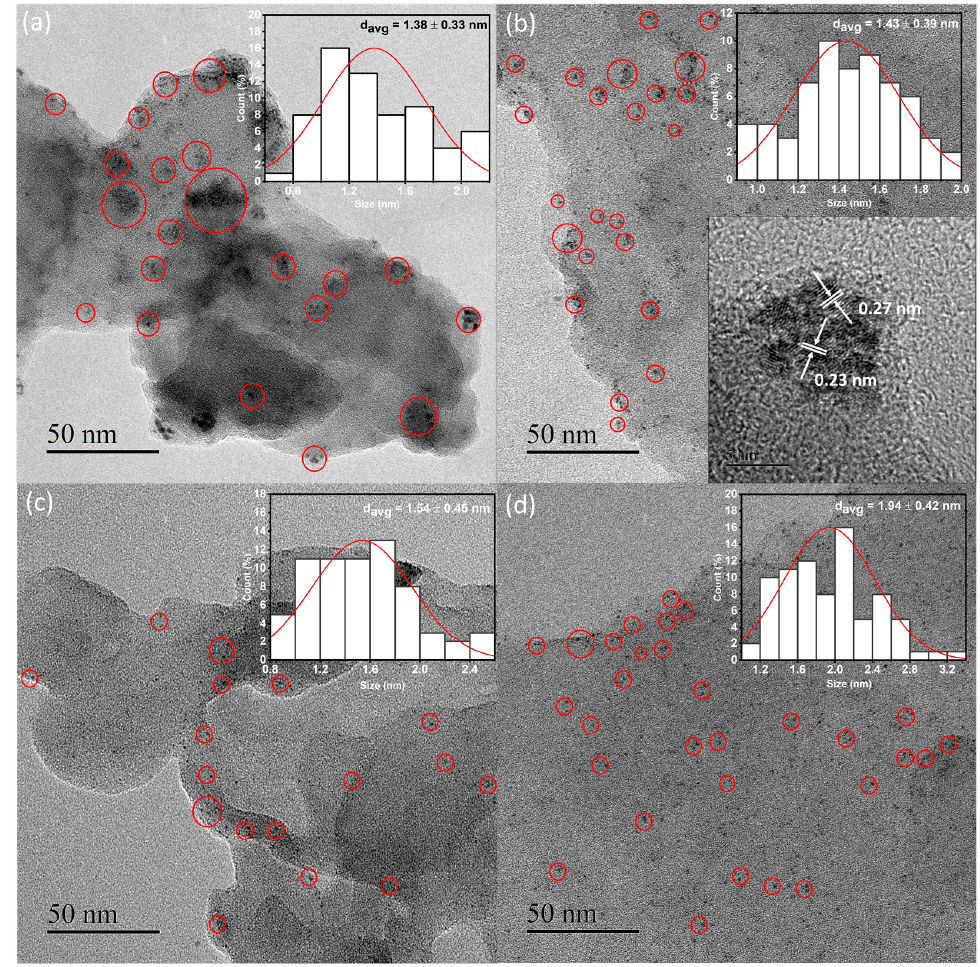
Figure 3. TEM images of the Pt/CN-140 ( a ), Pt/CN-160 ( b ), Pt/CN-180 ( c ), and Pt/CN-220 ( d ) photocatalysts. The insets of ( a – d ) are the size distribution of the Pt particles. Another inset in panel ( b ) is the corresponding HR-TEM image of the Pt/CN-160 photocatalysts.